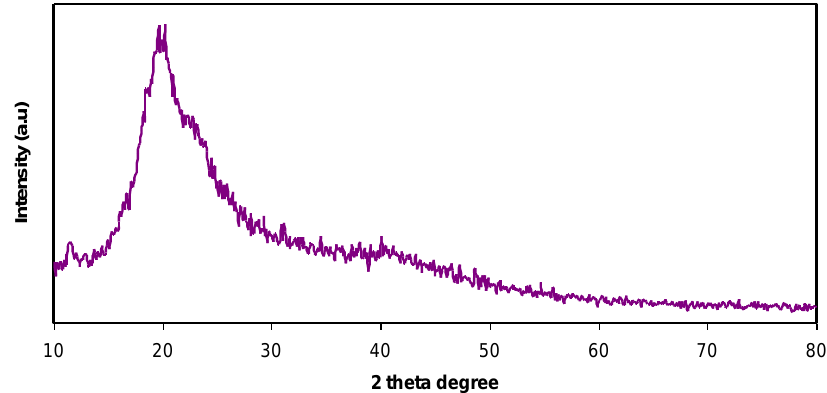
Figure 2. XRD pattern for PVA:CS [50:50] polymer blend films.